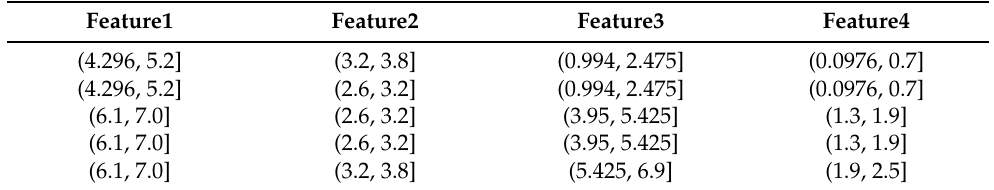
Table 2. Categorized data obtained after applying categorize_cols to the raw data example extracted from the iris data set presented in Table 1.